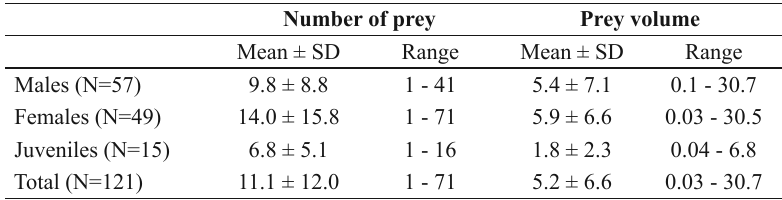
Number of prey and prey volume (mm 3 ) per stomach for males, females and juveniles of Phyllodytes luteolus in three restinga remnants along Brazil’s coast. SD = Standard deviation.